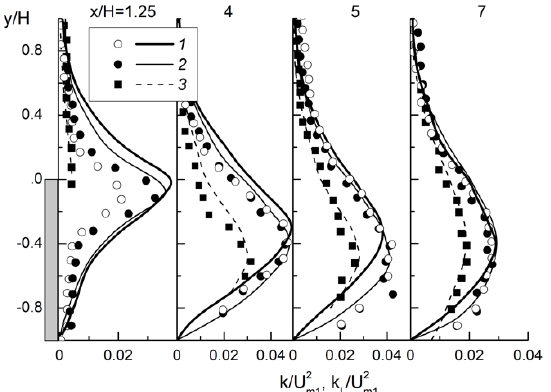
Figure 12. The profiles of turbulent kinetic energies of gas and dispersed phases. Symbols are the results of experiments of [16], lines are the author’s simulations. ER = 1.3. 1: single-phase air flow k 0 / U 2 ; 2: gas phase of droplet-laden mist flow k / U 2 2 m 1 M L 1 = 0.04, H = 20 mm.